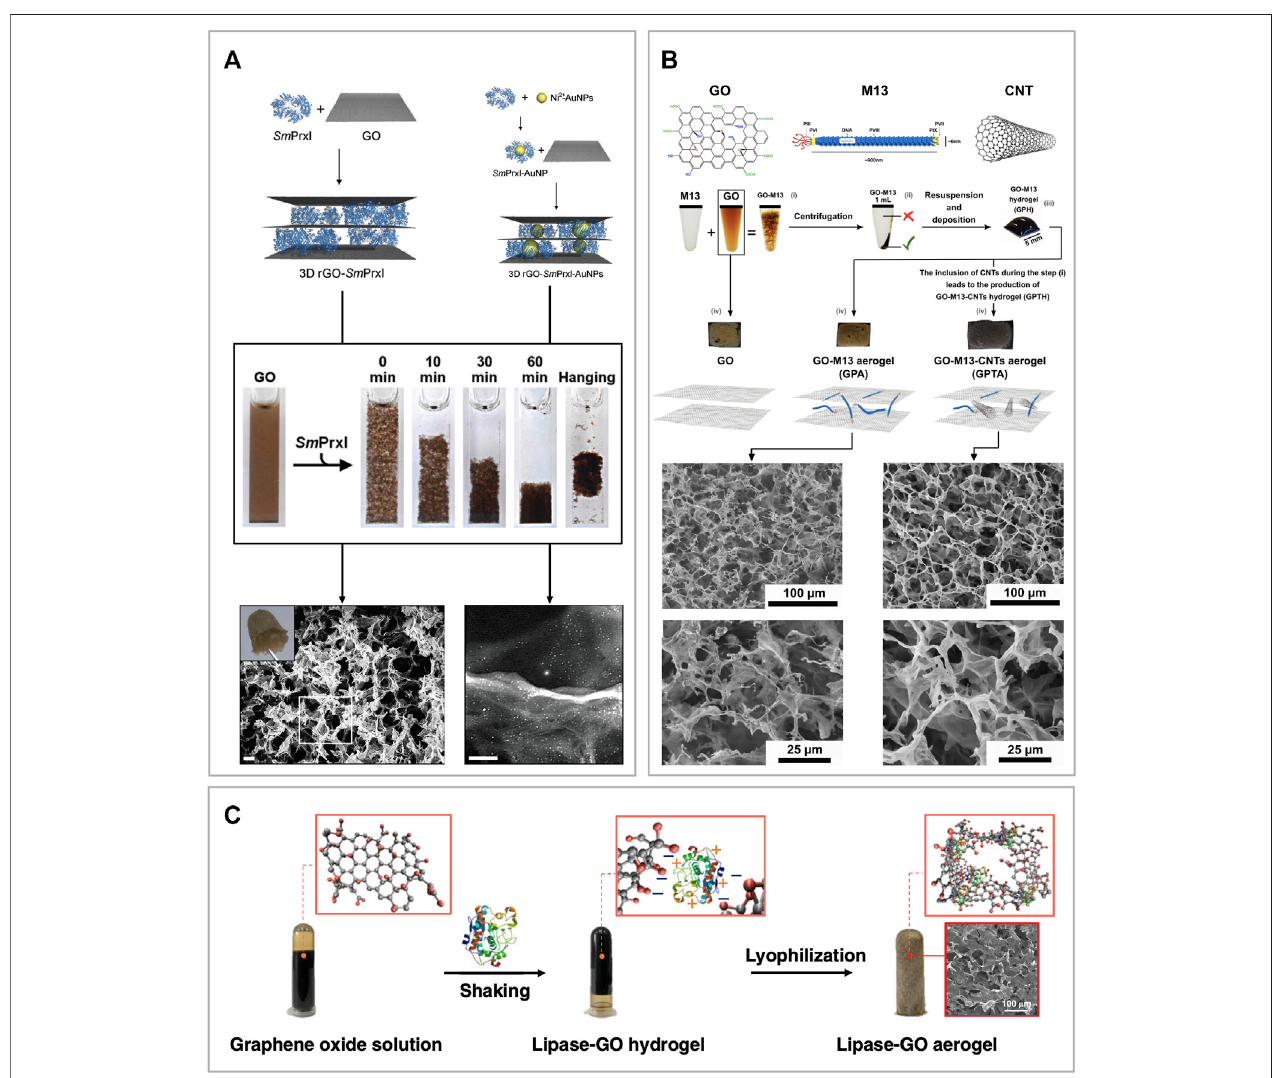
FIGURE5| Sponge-likegrapheneoxide-basedbiomaterials (A) Schematicoftheself-assemblymechanismwhere Sm PrxIringsadhere fl atoverthesurfaceofGO (top left corner). The same approach was employed to self-assemble the same composite but functionalized with gold nanoparticles bonded to the Sm PrxI (top right corner).The reaction is also shown in thepicture where itispossible tosee the GO in suspension, startingto assembleafter adding the Sm PrxI, and forming ahydrogel. At the bottom of the fi gure, the corresponding SEM images of the two composite materials after being freeze-dried to form an aerogel. Moreover, a picture of the fi nal aerogel isshown inthetop leftcorner ofthe GO- Sm PrxI SEMimage. Reprintedwithpermission(Ardiniet al.,2016). (B) Schematics ofGO, M13bacteriophage and CNT,followedbyanoverviewoftheself-assemblyprocessof GraPhage13 aerogels.Theprocessisdividedintofoursteps:i)assembly,ii)precipitation,iii)depositionand iv) drying. Images of the aerogels of GO, GO-M13 and GO-M13-CNT, as well as secondary electron SEM images of the samples at two different magni fi cations. Reprinted with permission (Sun et al., 2020). (C) Schematic of the one-step co-gelation and lyophilization after mixing GO and CALB solutions to prepare GO-CALB functional aerogel. Reprinted with permission (Xu et al.,